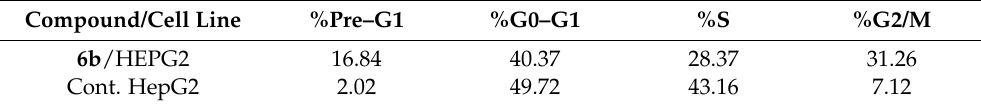
Table 5. Flow cytometric analysis of compound 6b .